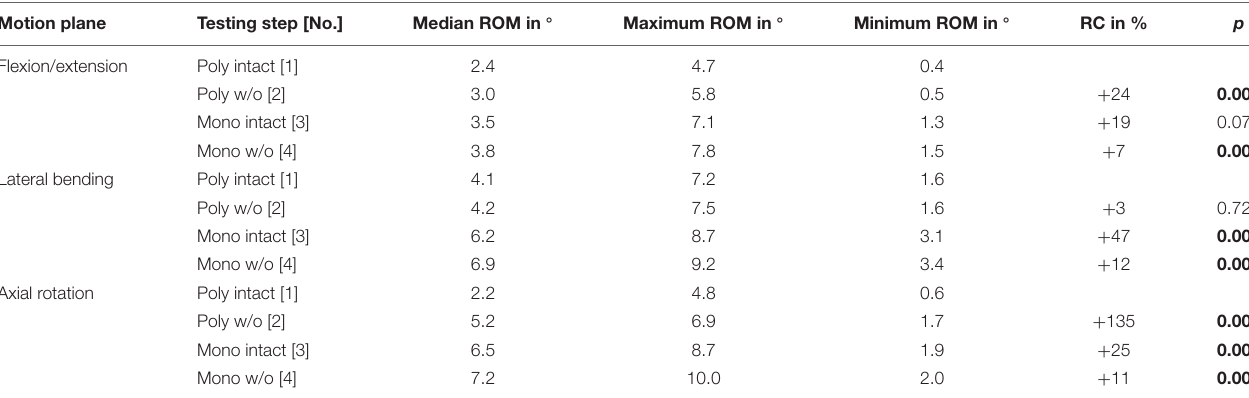
TABLE 5 | Results for T3-T4 range of motion at pure moments of ± 5 Nm ( n = 8) depending on primary motion plane and testing step. Motion plane Testing step [No.]